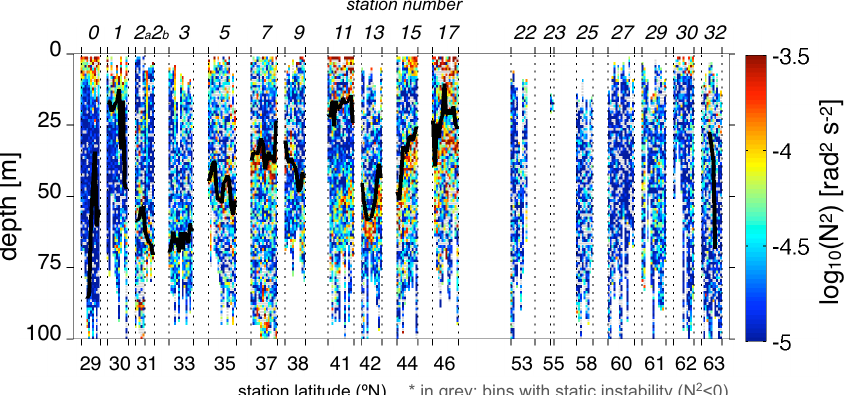
Fig. 4. Depth-binned profiles of the squared buoyancy frequency N 2 , derived from the SCAMP measurements along the transect. Station numbers are labelled on the top axis, and the corresponding latitude is shown on the bottom axis. The mixed layer depth (MLD) for each cast is also plotted as the thick black curve. The plot has a vertical bin resolution of 1m.